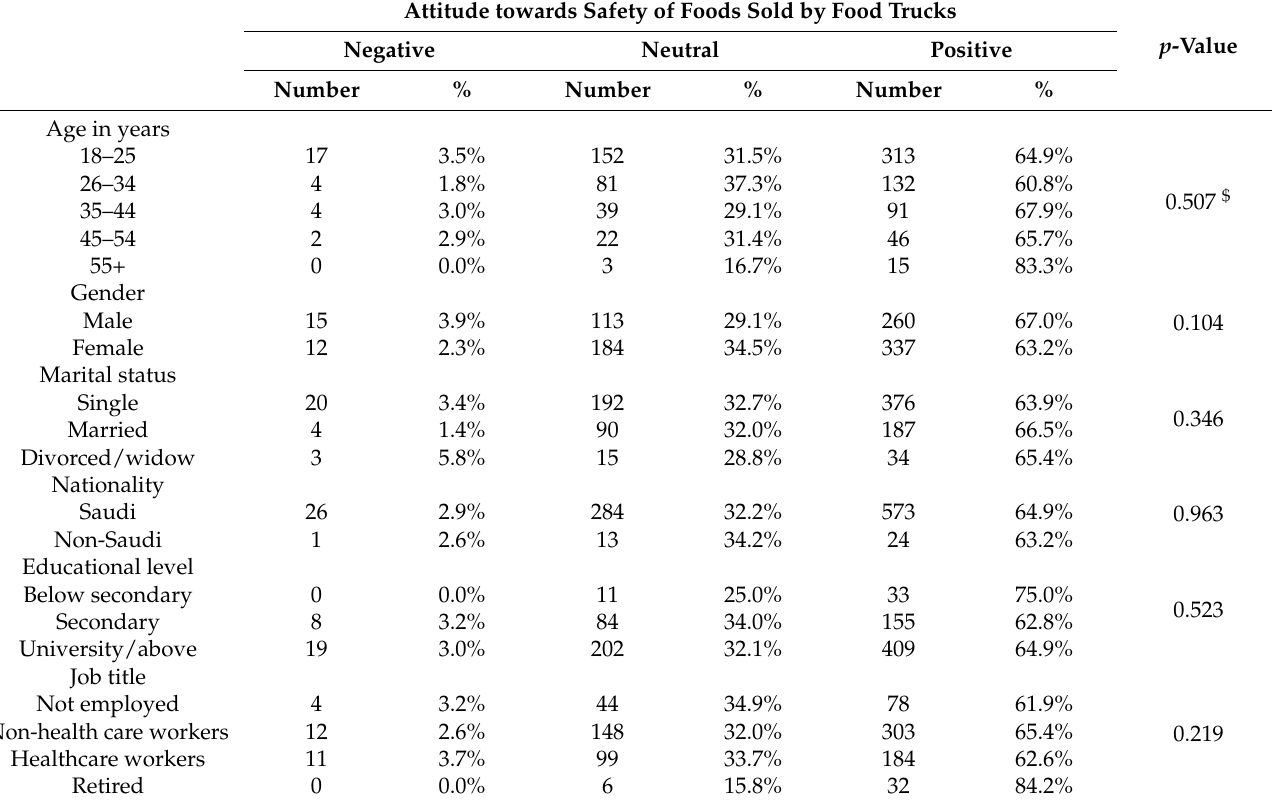
Figure 1. Overall attitude level of participants towards the safety of foods sold by the food trucks. As shown in Table 4, as far as participants’ attitude towards the safety of foods sold by FT is concerned, only monthly income was statistically significant on the Chi-square test. Participants who earned at least 15000 SR had a higher positive attitude (70%) compared to those who earned less ( p = 021) (Table 4). Table 4. Distribution of consumers’ attitude towards the safety of foods sold by the food trucks. Attitude towards Safety of Foods Sold by Food Trucks